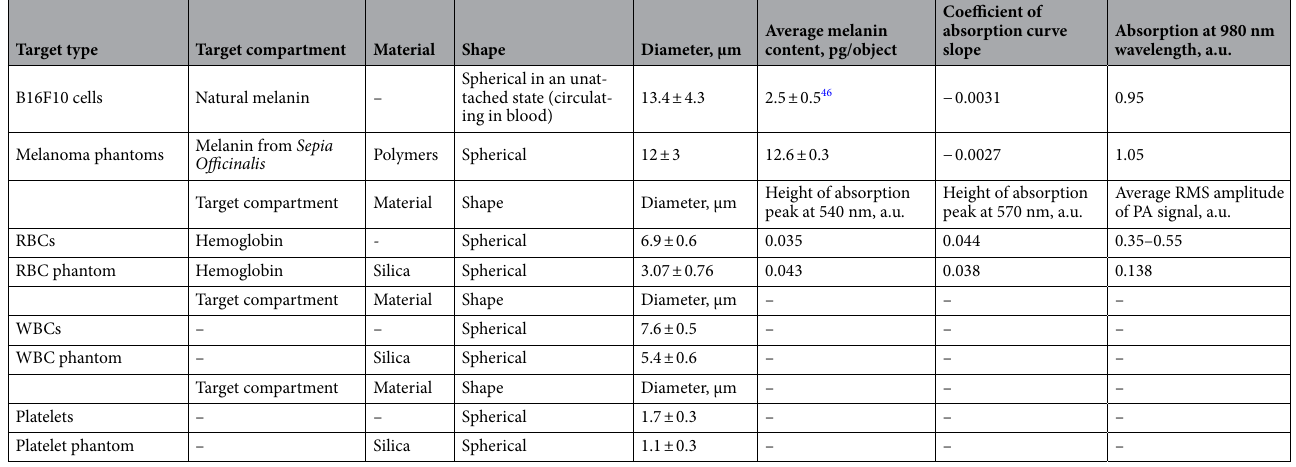
Table 1. The main characteristics of real cells and their